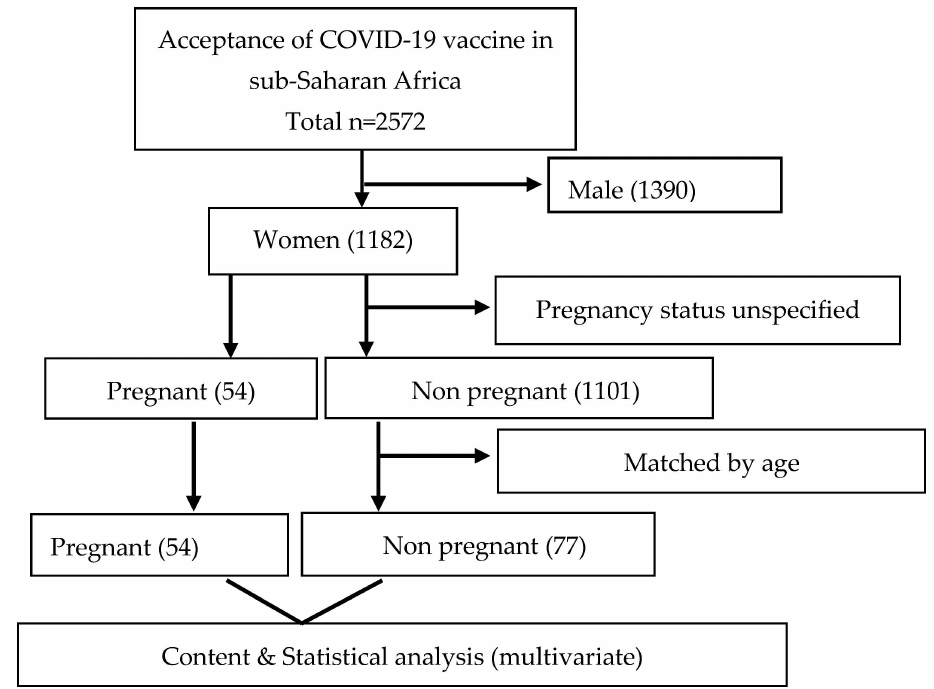
Figure 1. Flowchart of pregnant and non pregnant women in sub-Saharan